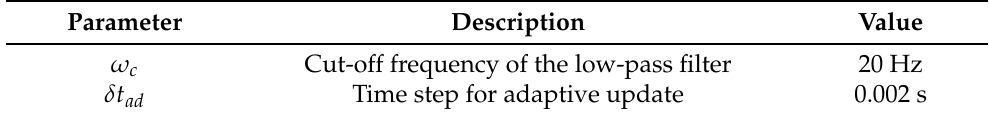
Table 2. Design parameters of L 1 adaptive control for longitudinal control.